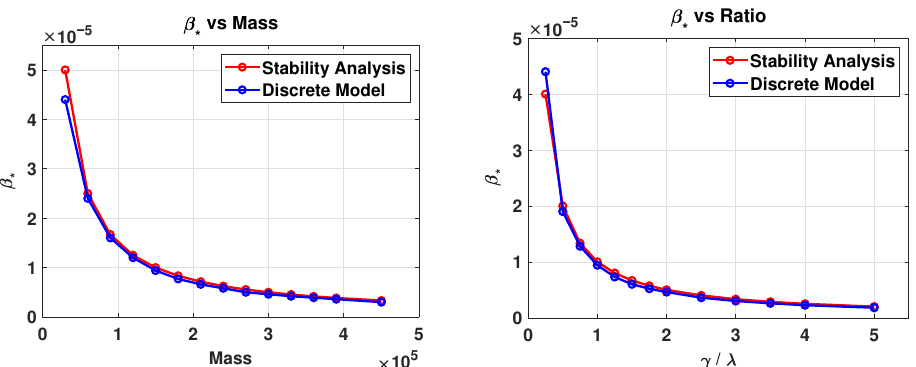
Figure 8. Critical β against the mass and γ ratio. The red curves represent critical β value from the λ linear stability analysis of the PDE system, and the blue curves represent the critical β value from the discrete model. Here we have δ t = 1 and the lattice size is 100 × 100. ( Left ) Critical β against = 1. ( Right ) Critical β against the ratio γ the mass when the ratio is γ when the mass is 50,000. We λ λ see that the phase transitions occurs at a smaller β value whenever as the systems’ mass increase or when the γ ratio increase. We also see that the critical β value of both the discrete model and the λ PDE system match, and this is a good indicator that our continuum equations replicate the behavior of the discrete